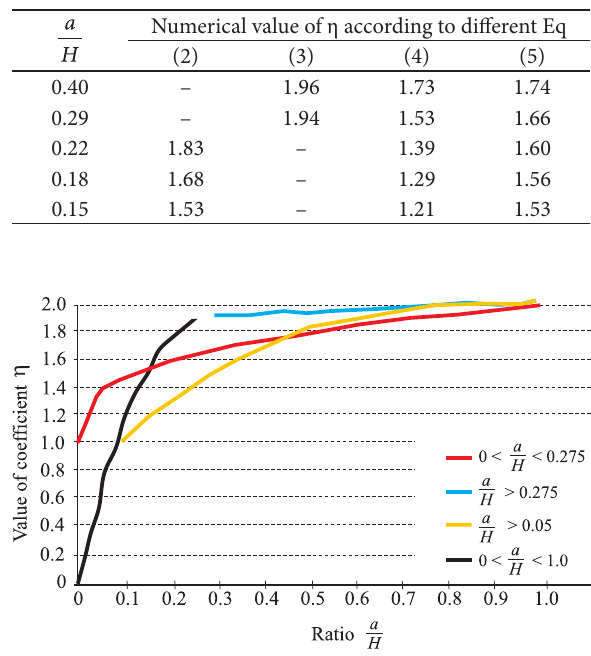
Fig. 2. Application boundaries of formulas listed in Table 1